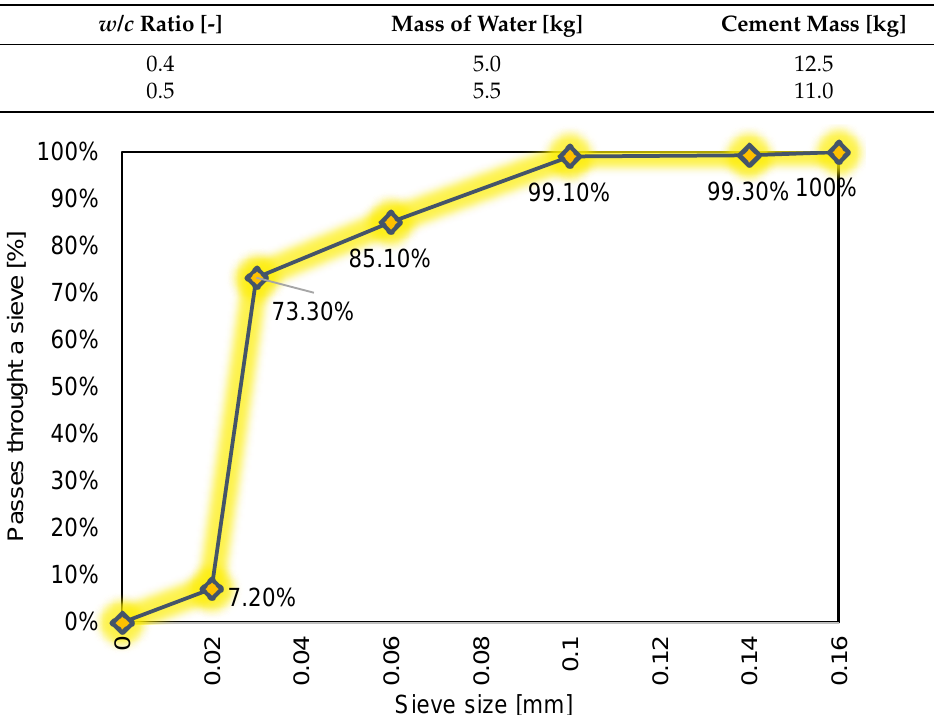
Table 2. Cementitious mixes used to prepare the samples.